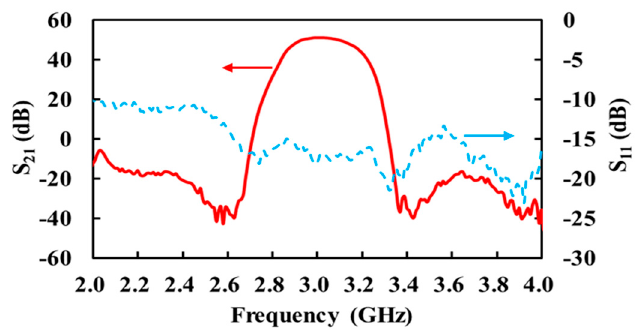
Figure 4. Measured S-parameters of the receiver.